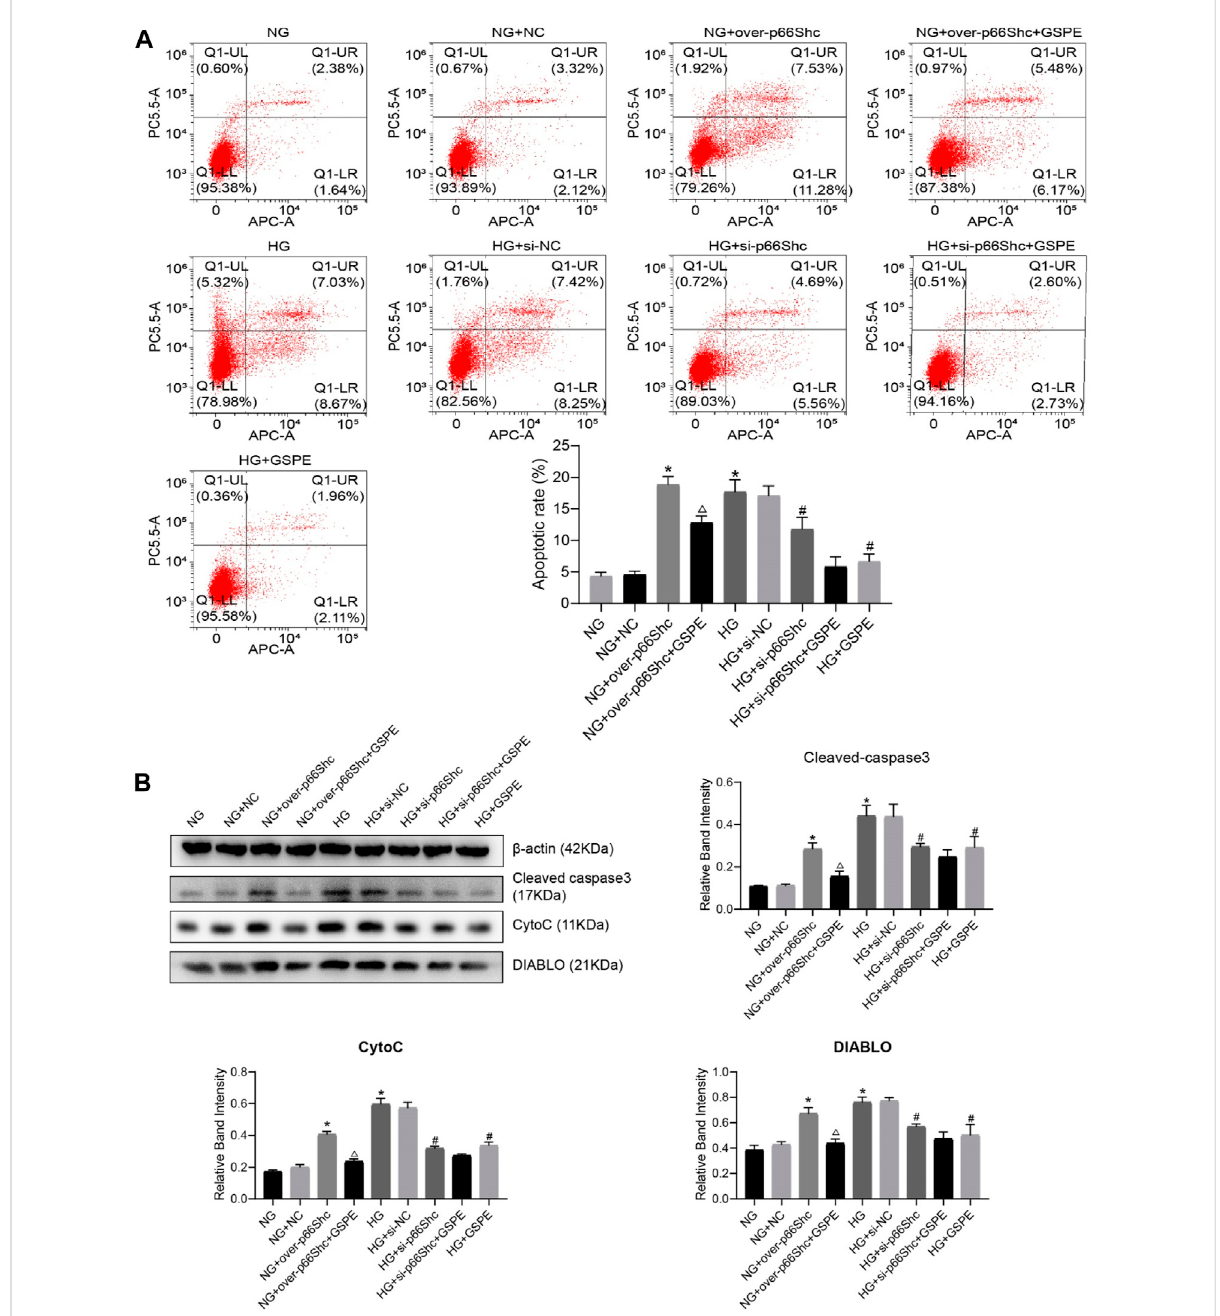
FIGURE 8 (A) Flow cytometry analysis of apoptosis in cultured HK-2 cells in different groups and quantitation of these results. Mean ± SD. n = 3. p p < 0.05 vs. NG group; # p < 0.05 vs. HG group; △ p < 0.05 vs. NG + over-p66Shc group. (B) Western blot for determining the protein levels of mitochondrial associated proteins (Cleaved caspase-3, CytoC, and DIABLO) in each group and quanti fi cation of bands. Mean ± SD. n = 3. p p < 0.05 vs. NG group; # p < 0.05 vs. HG group; △ p < 0.05 vs. NG + over-p66Shc